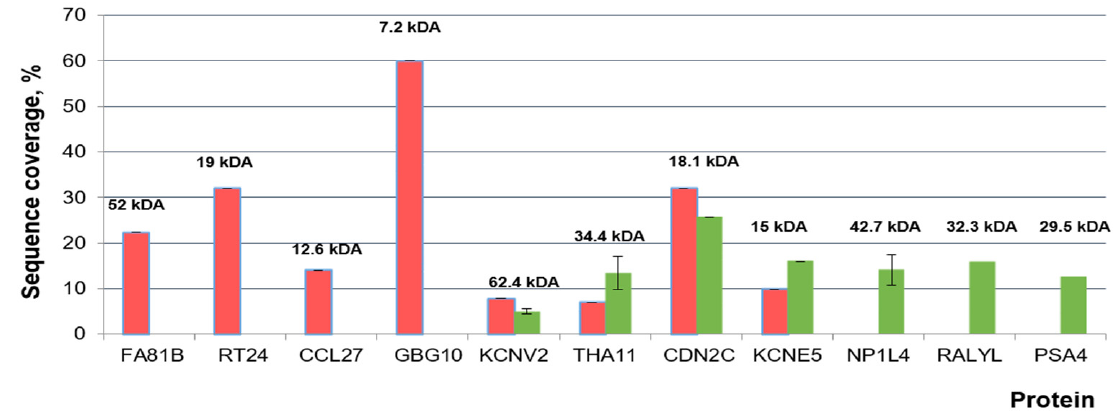
Figure 4. The bar graph displays the sequence coverage of proteins in the MALDI-TOF MS analysis. Proteins found on the chip surface, functionalized with oligonucleotides after incubation in blood samples from ASD patients (red bars, n = 7) and healthy volunteers (green bars, n = 4). Indicated are the values of the standard deviation of the measurement results, the molecular weight of the proteins.